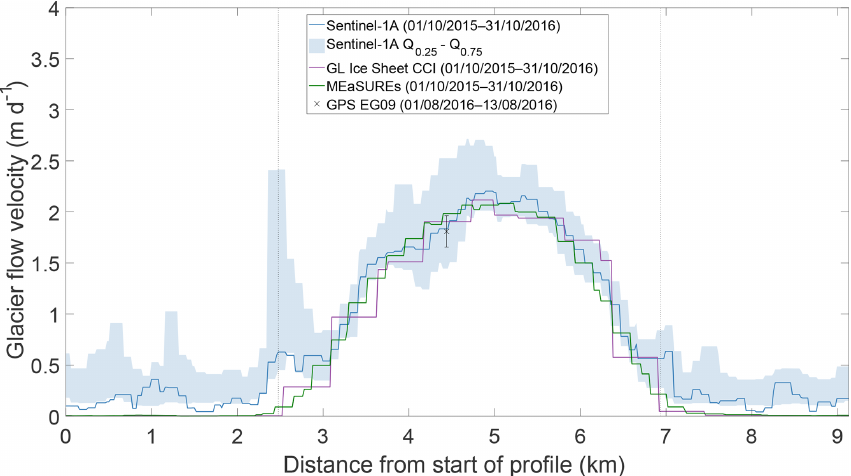
Figure 15. Mean annual flow speed across the position of GPS tracker EG09 (see Fig. 1) between 1 October 2015 and 31 October 2016 (13 months) for different products, starting at the orographic left side of the glacier. The dashed lines depict the glacier’s margins. Note the peak at the orographic left margin emerges from a debris covered marginal